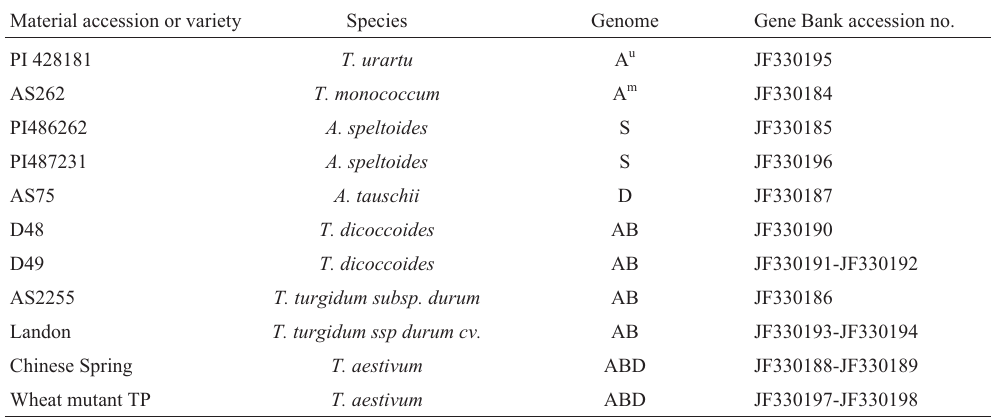
Table 1 - Plant materials of Triticum and Aegilops accessions used in this